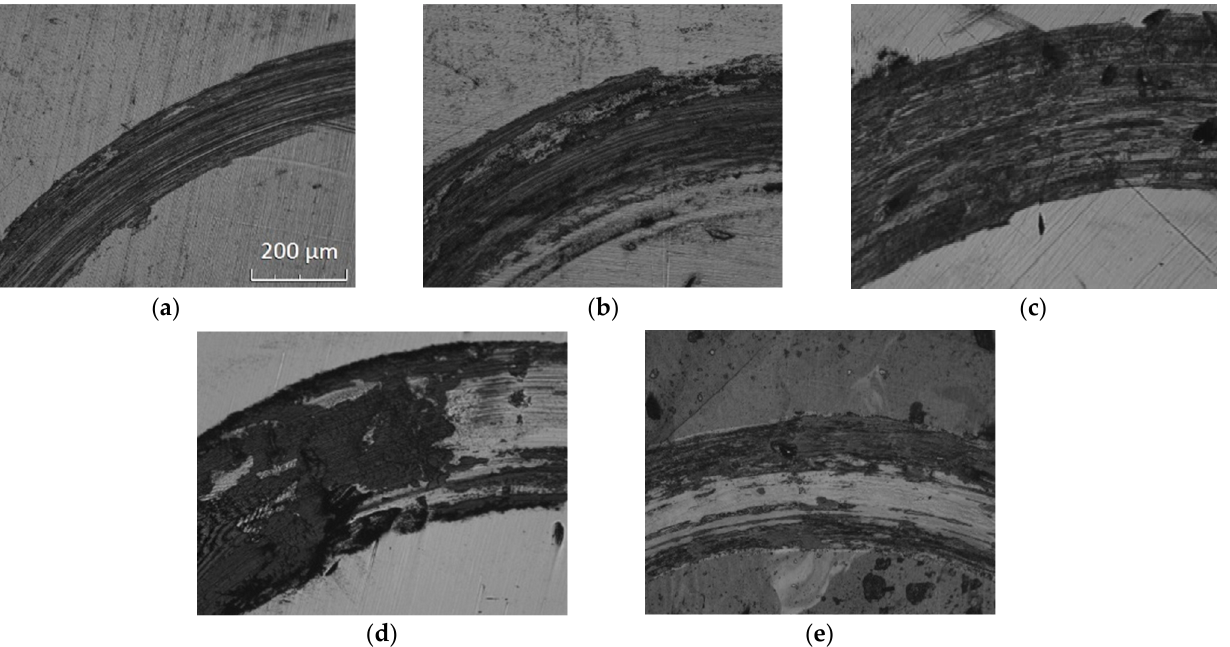
Figure 7. Wear track of Fe 6 CoCrNiAl coating: ( a ) 1 N, RT; ( b ) 5 N, RT; ( c ) 10 N, RT; ( d ) 10 N, 373 K; ( e ) 10 N, 573 K.